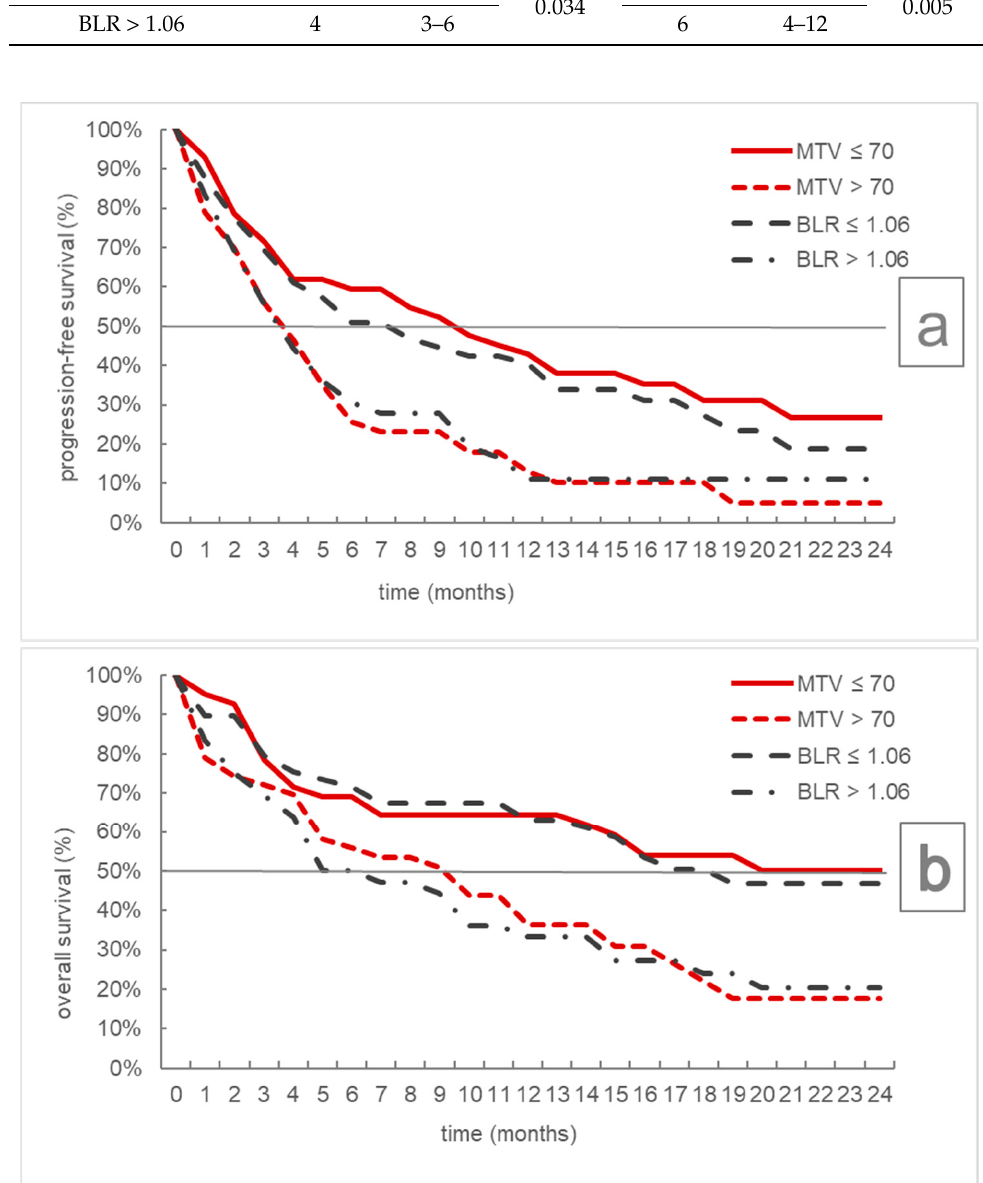
Figure 2. Kaplan–Meier curves for progression-free ( a ) and overall survival ( b ) according to MTV and BLR subgroups. MTV = metabolic tumor volume, BLR = bone marrow to liver ratio. The best radiological response according to RECIST for MTV and BLR subgroups is visualized in Table 3. Response rates differed significantly between patients with MTV ≤ />